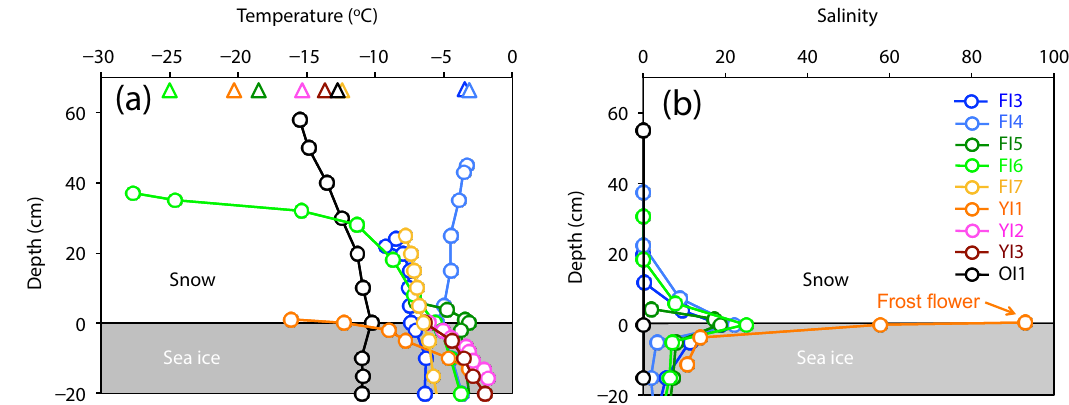
Figure 5. Vertical profiles of temperature (a) and salinity (b) in snow and sea ice (top 20cm). The horizontal line indicates snow–ice interface. Shaded area indicates sea ice. The triangle in panel (a) indicates the air temperature for each station. For stations FI7 and YI2 and 3, we have no salinity data.